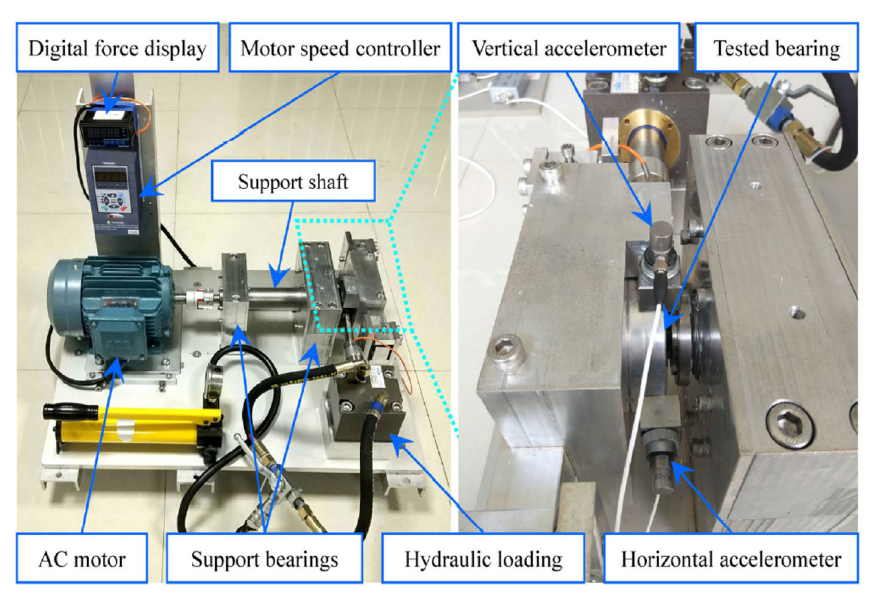
Figure 12. Testbed of rolling element